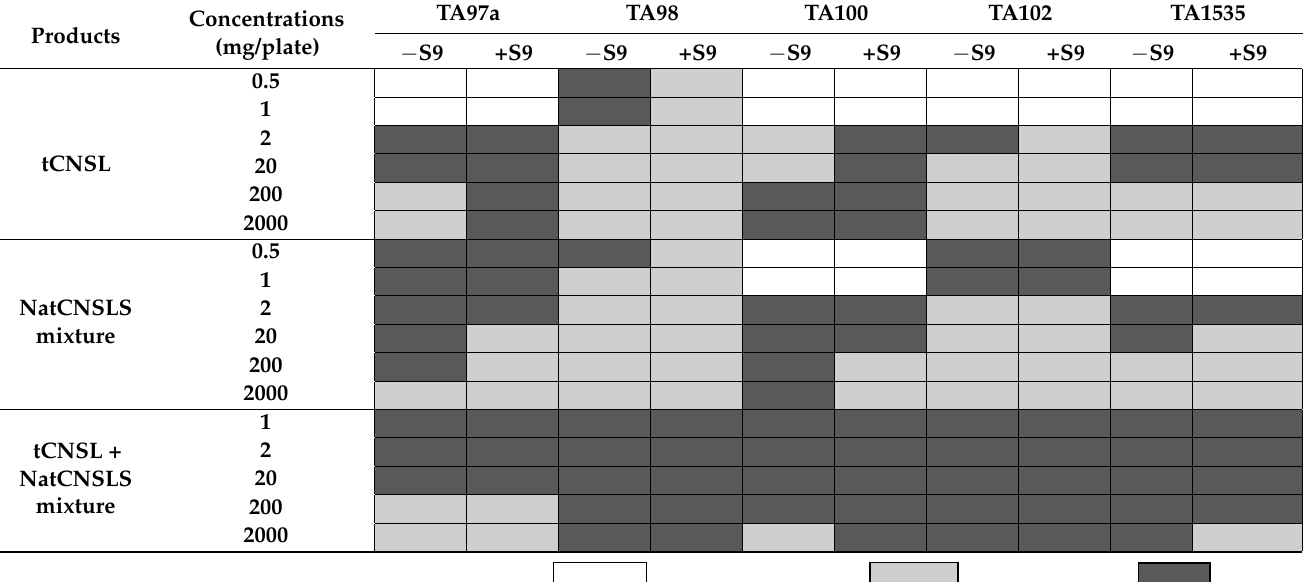
Table 5. Mutagenic activity of tCNSL + NatCNSLS mixture and its constituents (tCNSL and NatCNSLS mixture) expressed by the mutagenicity ratio (MR) for strains TA97a, TA98, TA100, TA102 and TA1535 in the absence ( − S9) and presence (+S9) of metabolic activation.